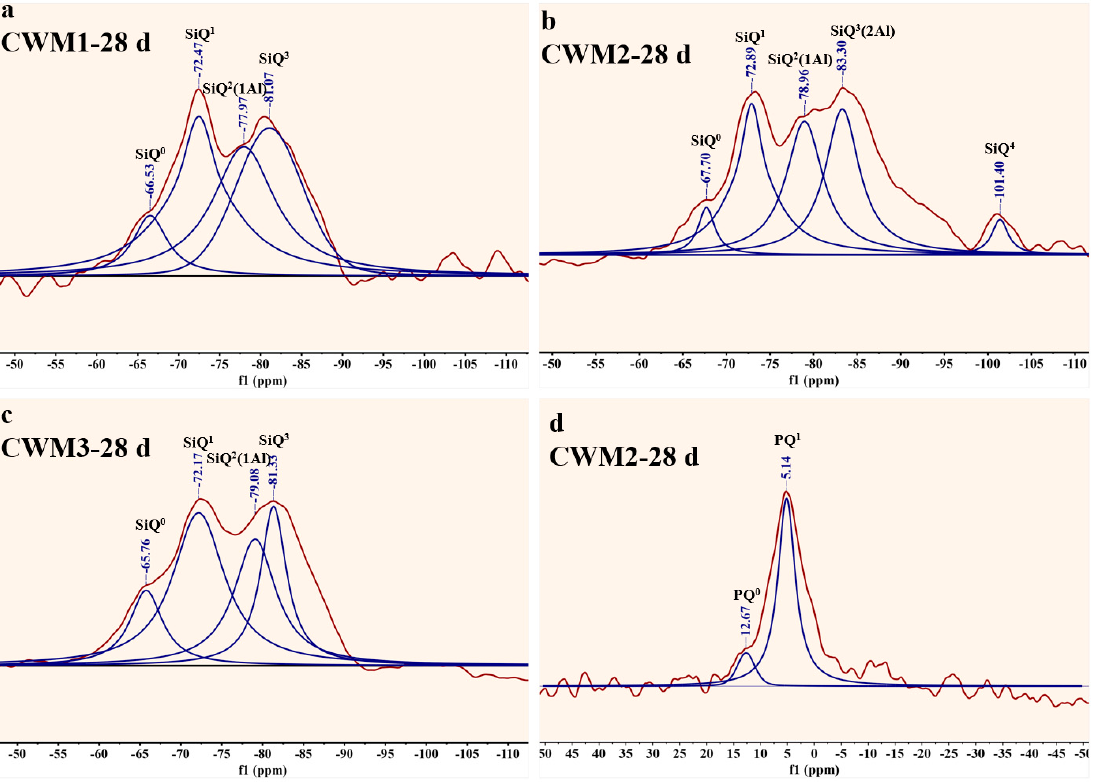
Figure 12. 29 Si NMR and 31 P NMR data graph of the CWM. ( a ) CWM1-28d, ( b ) CWM2-28 d, ( c ) CWM3-28 d, ( d ) CWM2-28 d ( 31 P NMR).